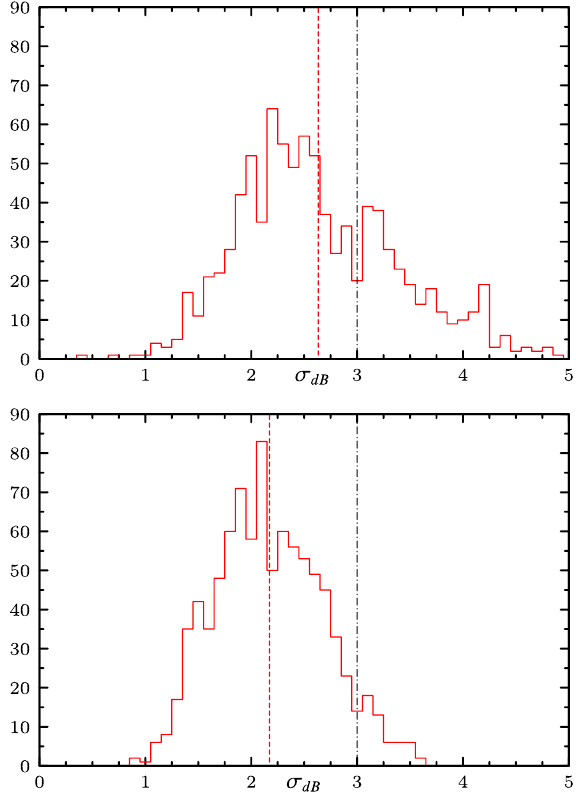
Figure 9: Histograms of values of σ dB numerically ob- tained (via the DGT) in the two configurations of the RC shown in Fig. 7. As previously the losses are introduced via 6 patchs of very low conductivity leading to d (cid:46) 1 . Also shown: the limit at 3dB (black dash-dots) and the mean of σ dB (red dashes). Above: histogram for the con- ventional RC with the stirrer ( (cid:104) σ dB (cid:105) = 2 . 63 ). Below: his- togram for the chaotic RC with 3 half-spheres and the stirrer ( (cid:104) σ dB (cid:105) = 2 . 17